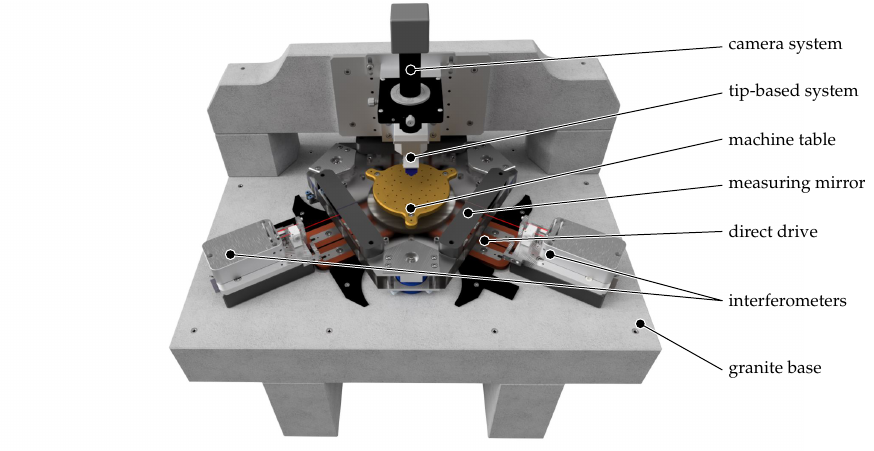
Figure 3. CAD model of the Nanofabrication Machine (NFM-100). The AFM measuring system is mounted directly above the centre of the machine table.